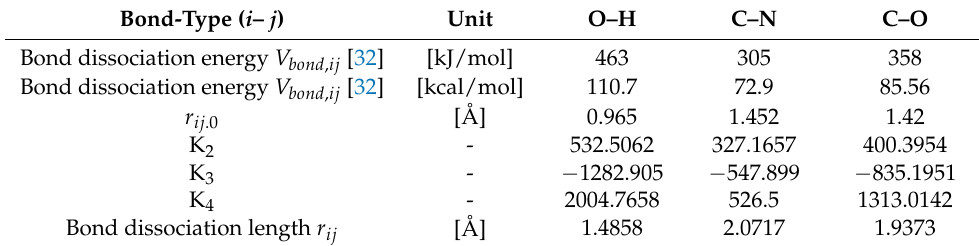
Table 3. The bond dissociation length of the newly created